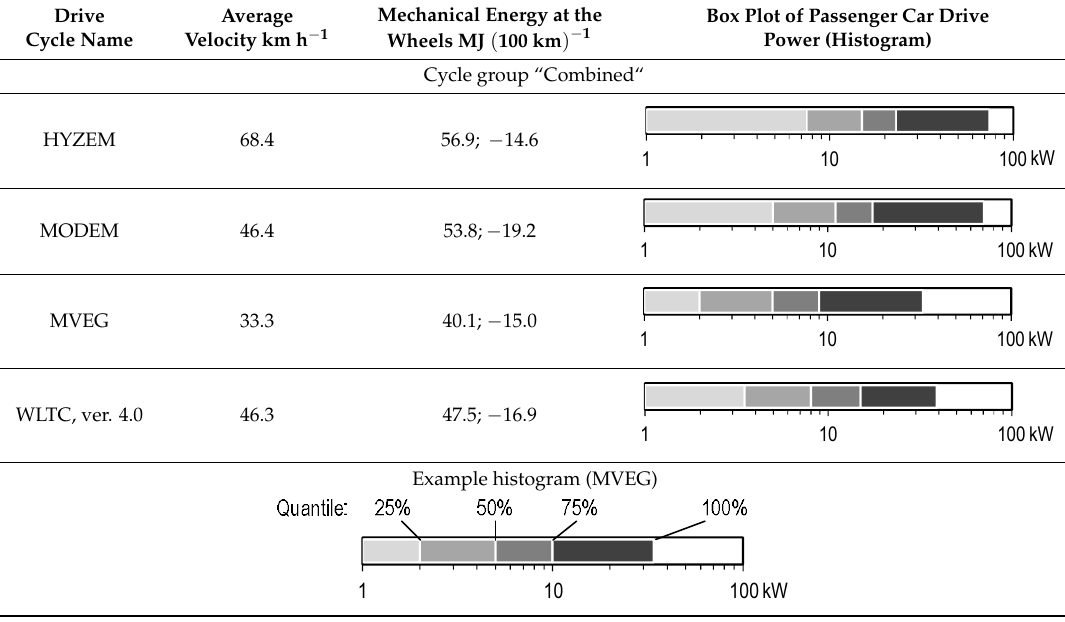
Table A3. Vehicle mass (kg) and power of an IC engine and electric machine (kW) of all concepts examined. Concept A-Segment ICV-G